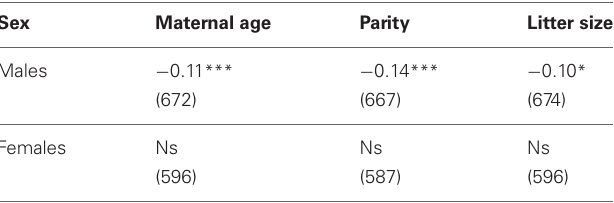
Table 3 | Spearman rank correlations between lifespan and maternal